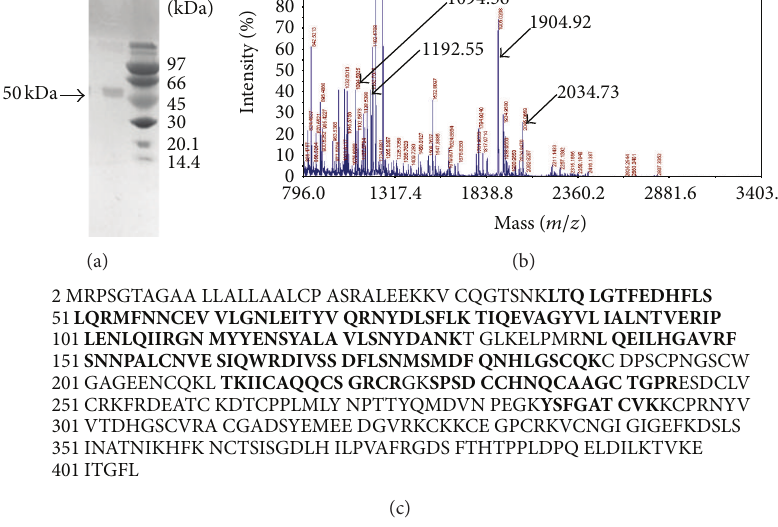
Figure 3: Identification of the truncated protein by MALDI-TOF/TOF analysis. (a) The gel in the inset shows the purified N-terminal truncated EGFR with its corresponding size. The protein masses of the BioRad markers are indicated in kDa. (b) The spectrum shows different peaks of the MS analysis done by MALDI-TOF. The N-terminal truncated EGFR ( ≈ 50kDa) was subjected to in-gel trypsin digestion before MALDI-TOF analysis. The arrows show the peaks that served for MS/MS analysis with their corresponding masses used for protein identification. (c) MASCOT results: matched peptides to EGFR sequence are shown in capital bold; the last identified peptide ends at